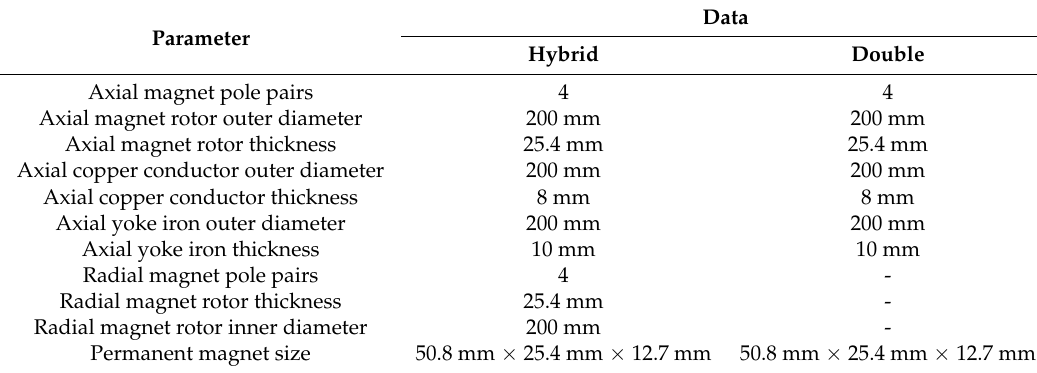
Table 1. Dimension parameters of the magnetic coupler.